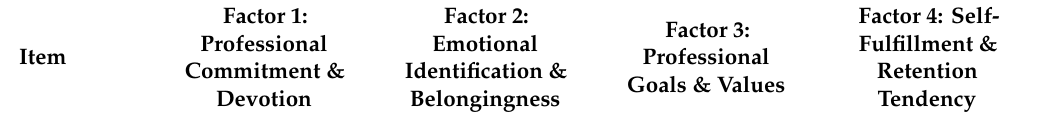
Table 2. Rotated factor loading of the EFA model for the